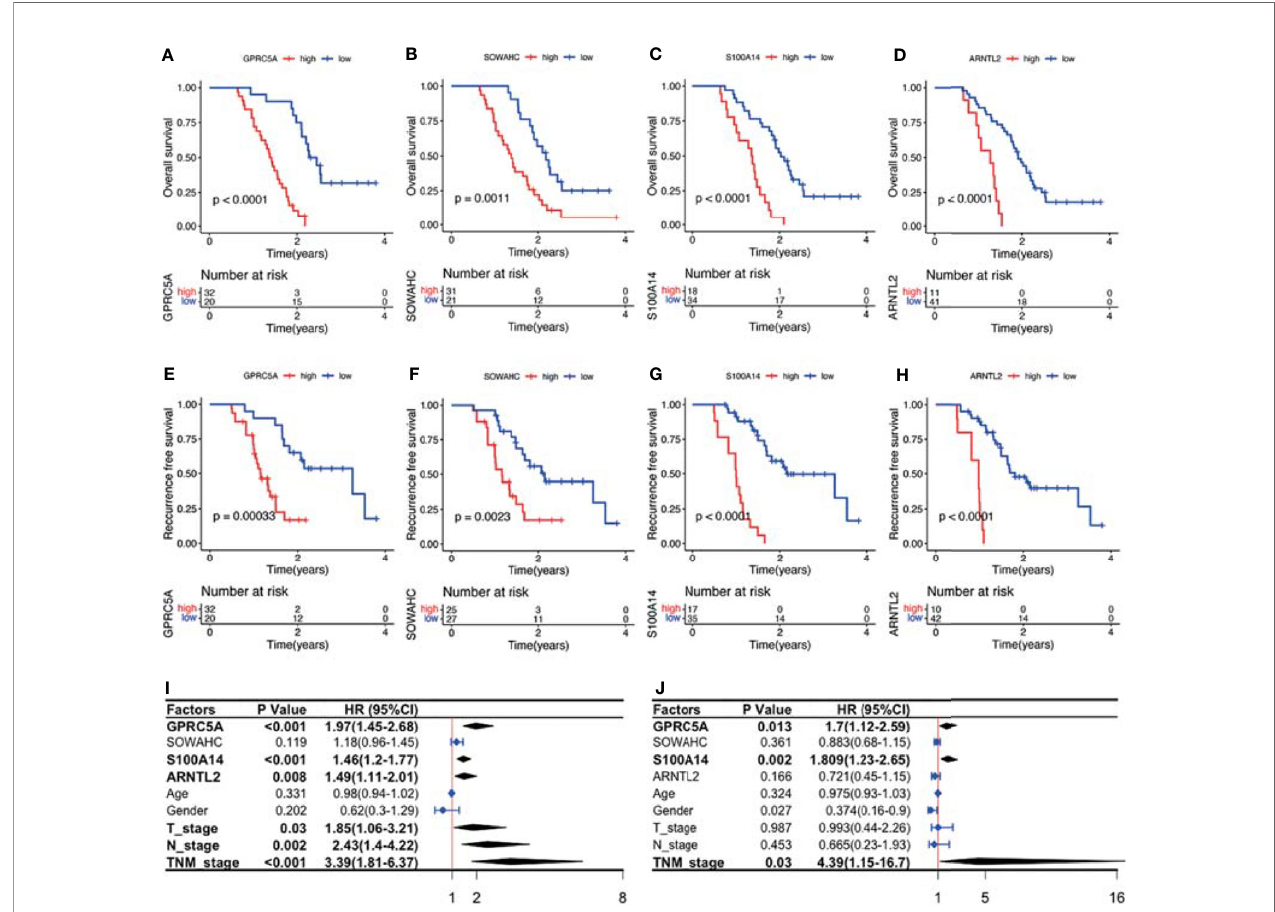
FIGURE 12 | Survival analysis and Cox regression analyses of the association between the four MDG protein levels and patient prognosis. (A – H) The MDG protein expression levels were associated with shorter OS and RFS. (I, J) Uni- and multi- variate cox regression analyses of the clinicopathological factors of